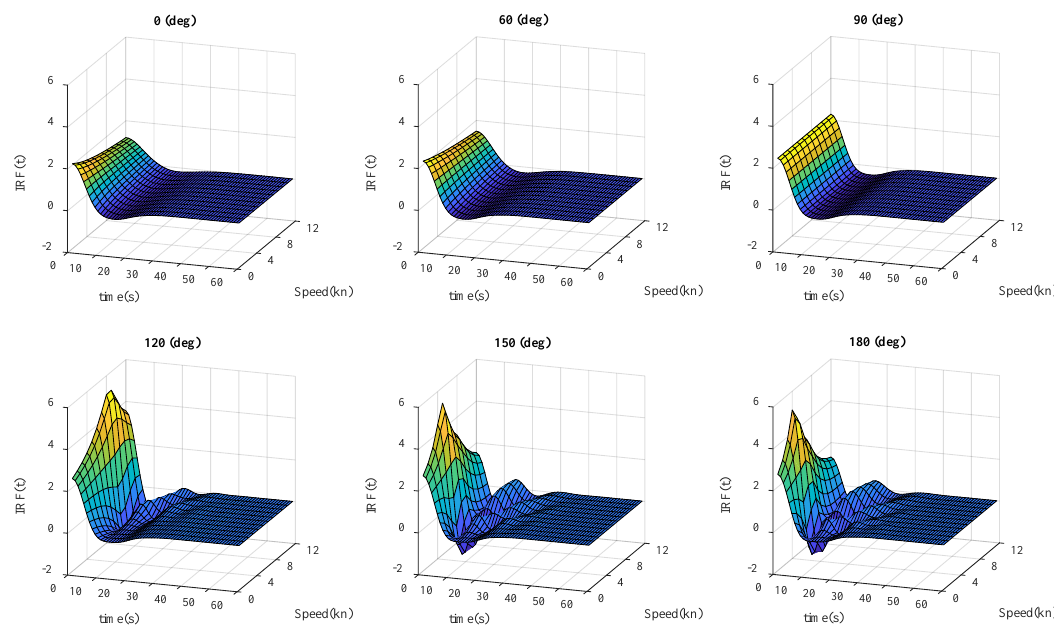
Figure 22. Impulse response functions.